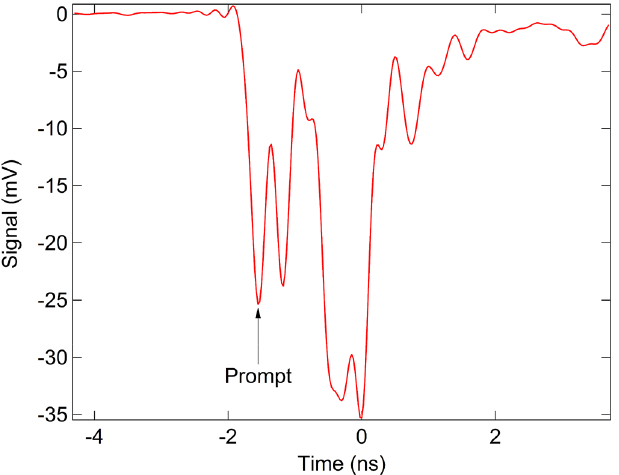
FIG. 3. Detector response for a single pass of the bunch. In this study we are only interested in the prompt peak. The meaning of the other structures is described in